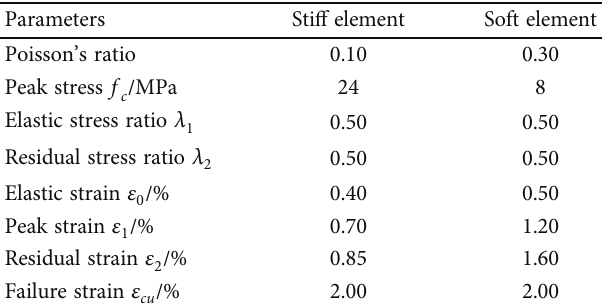
Table 2: Compressive stress – strain parameters of the sti ff and soft